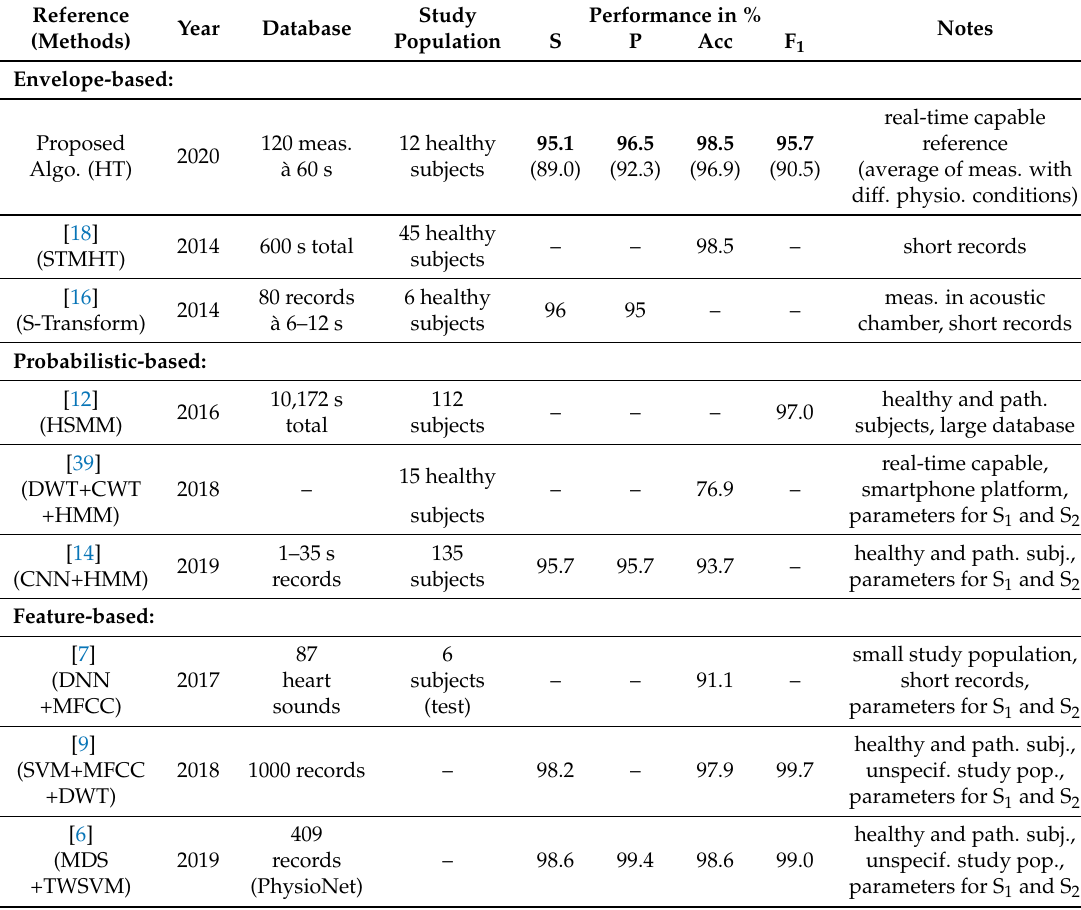
Table 9. Comparing the performance of the proposed algorithm with the state of the art heart sound classification algorithms. The performance parameters S, P, Acc and F 1 correspond to the sensitivity, precision, accuracy and F 1 -score, respectively. The performance parameters are only related to S 1 , if not stated otherwise in the